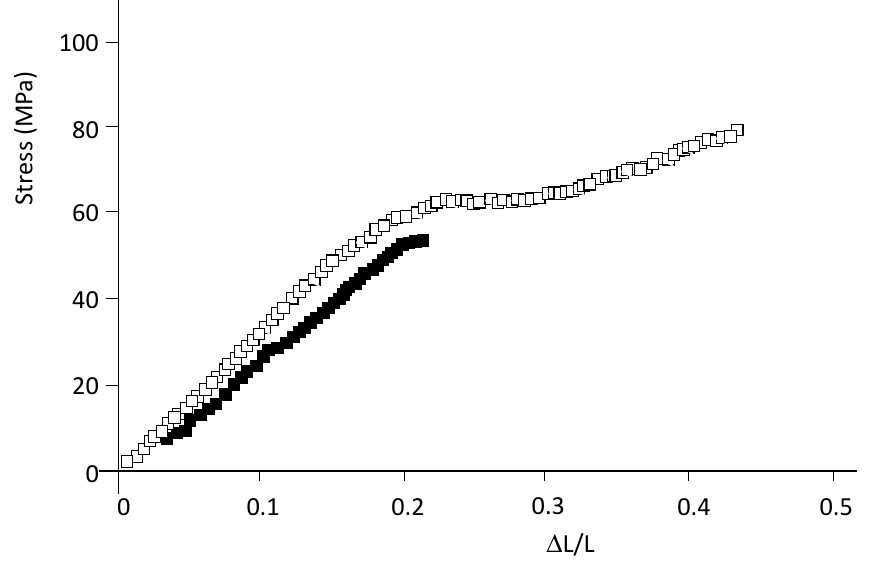
Figure 6. Stress–strain curves from compression tests for DGEBA ( n = 0)/mXDA /AuNP (8.5%) ( □ ) and DGEBA ( n = 0)/mXDA ( ■ ). Table 6. Young’s modulus and bending modules for DGEBA/mXDA/AuNP (8.5%) and DGEBA ( n = 0)/mXDA systems.